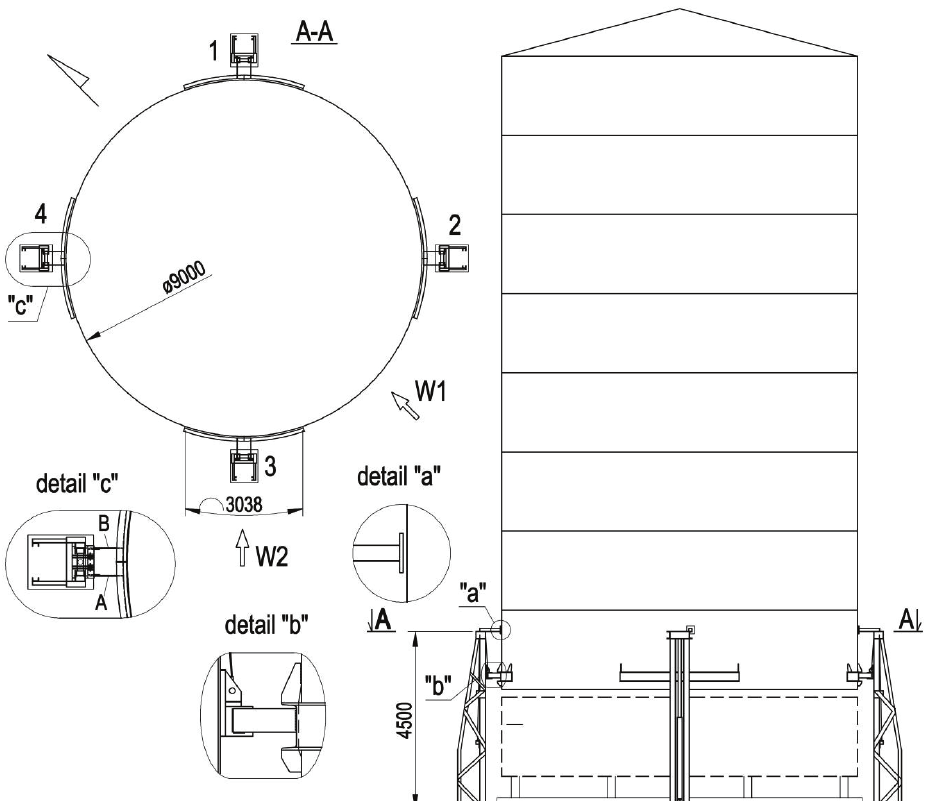
Figure 2: Scheme of the tank Fig. 2. Scheme of the tank assembly